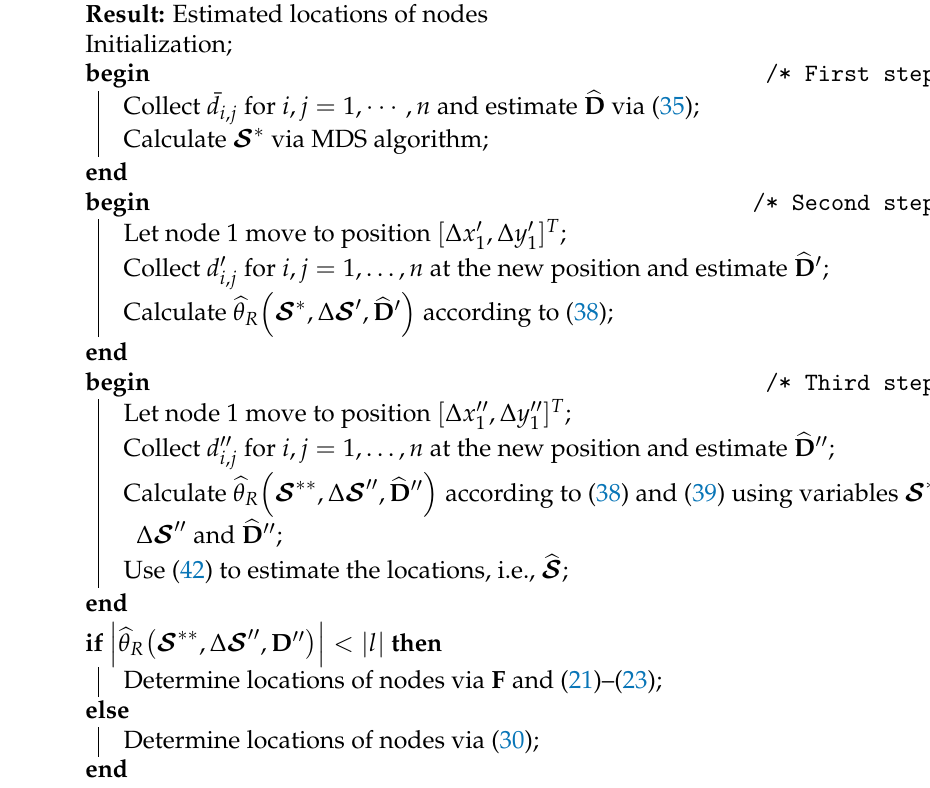
Algorithm 1: Algorithm to estimate locations of mobile nodes.